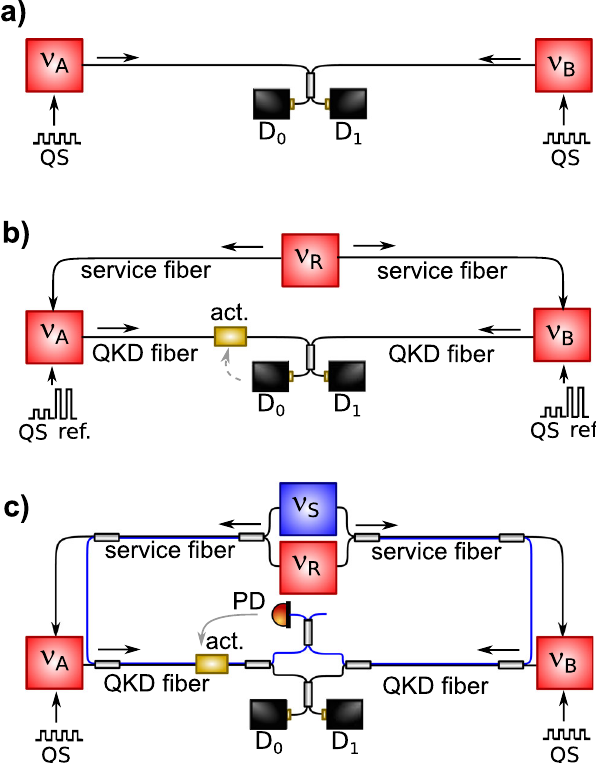
Fig. 1 Principle schemes of TF-QKD. a In ideal TF-QKD, Alice and Bob encode quantum states (QS) on local lasers, attenuated to the single- photon level and with equal frequencies ν A = ν B . The resulting signals are sent to Charlie, where they interfere on single-photon detectors (D 0 and D 1 ). b In practical implementations, a reference laser with frequency ν R is sent to Alice and Bob through a service fi ber, to phase-lock the QKD lasers and ensure ν A = ν B = ν R . After information encoding, QKD lasers are sent to Charlie through the QKD fi bers. The transmission of QS is periodically interrupted to send reference phase states encoded in higher-intensity photon pulses (ref.), that allow detection of changes in the propagation path induced by length and refractive index fl uctuations of the fi ber. These are counteracted by either adjusting the phase of the incoming lasers through an actuator (act.) or by taking into account the instantaneous phase misalignment between the QKD fi bers in post-processing. c In our approach, an additional sensing laser with frequency ν S travels the service fi ber with the reference laser, and the QKD fi bers together with the QKD lasers. It can be spectrally separated because ν S falls in a different channel of the dense wavelength-division multiplexed (DWDM) grid. While QKD lasers interfere on D 0 and D 1 , the classical signals at ν S are phase-compared on a photodiode (PD) to detect the noise of both the service and QKD fi bers. This allows tight control of the fi ber noise and simultaneous key